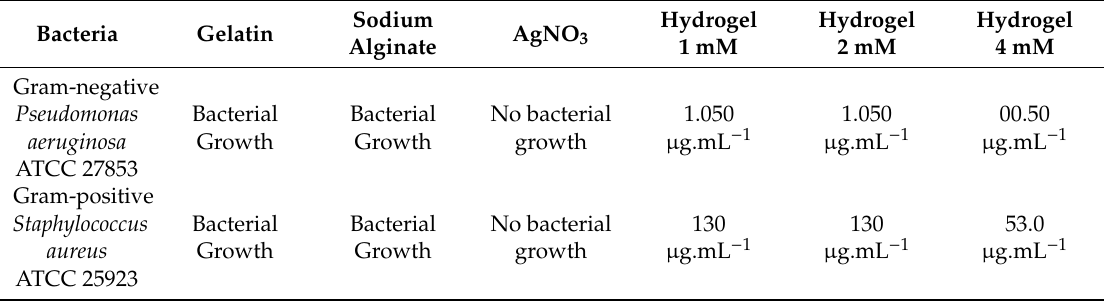
Table 1. MIC of the gelatin, sodium alginate, and silver nitrate solutions, hydrogels with